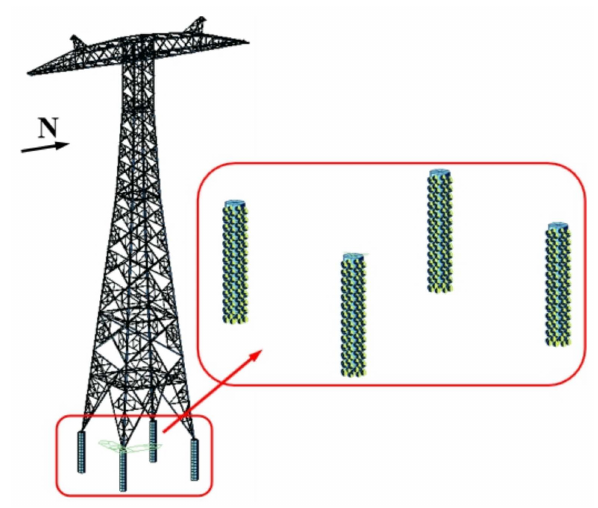
Figure 4. Transmission tower finite element